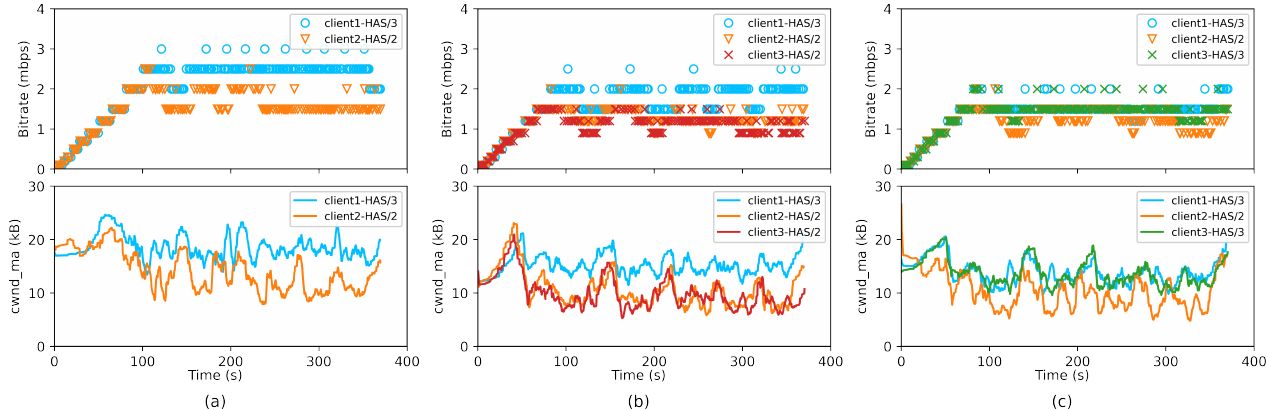
Figure 6. The representative time-varying bitrates and cwnd _ ma of the clients running the fairness ABR with B = 5 (mbps), under the scenario ( a ) S 11 , ( b ) S 12 and ( c ) S 21